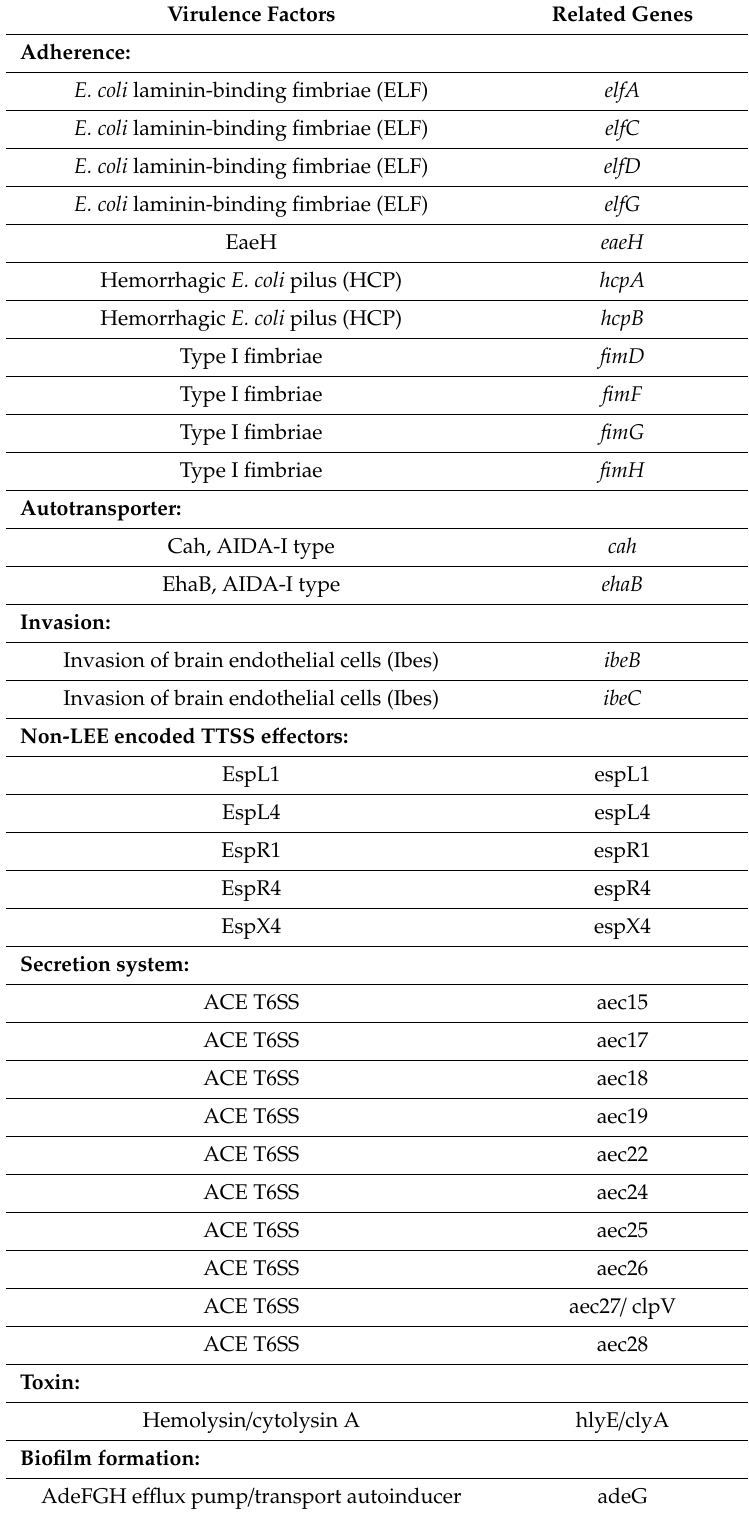
Table 2. The virulence genes found in H 2 S-producing E. coli isolate.